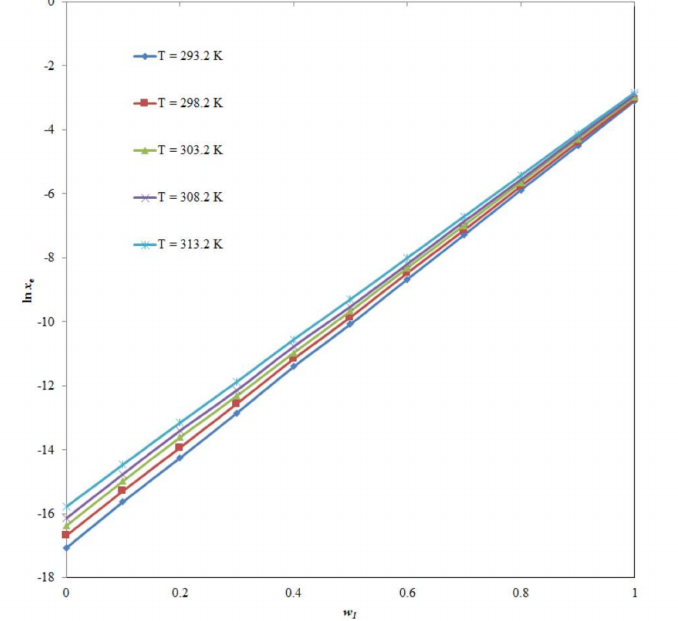
Figure 2. Influence of Transcutol-P (TP) mass fraction ( w 1 ) on logarithmic solubilities of CNZ between 293.2 and 313.2